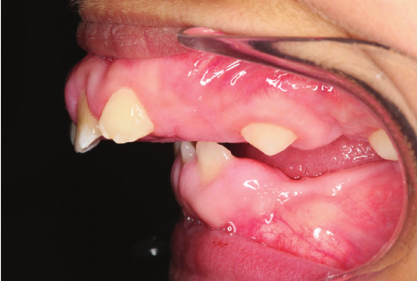
Figure 2: Excessive overjet.